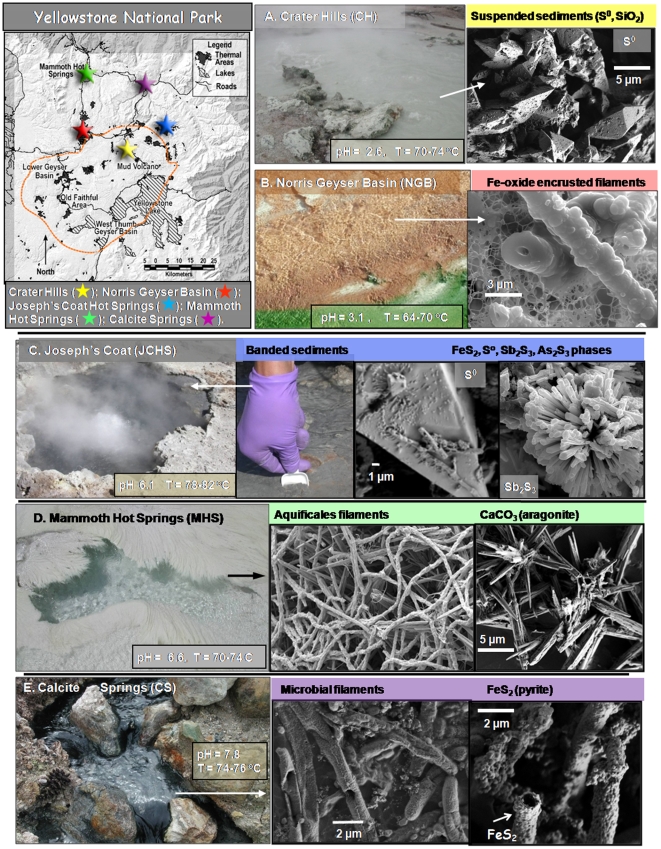
Habitat context and geothermal site characteristics.Site photographs and scanning electron micrographs (SEM) of microbial mats and solid phases associated with each geothermal sample used for metagenome sequencing (map of Yellowstone National Park and site locations shown in top left panel). A. Crater Hills (CH, gold); B. Norris Geyser Basin (NGB, red); C. Joseph's Coat Hot Springs (JCHS, blue); D. Mammoth Hot Springs (MHS, green). E. Calcite Springs (CS, violet).